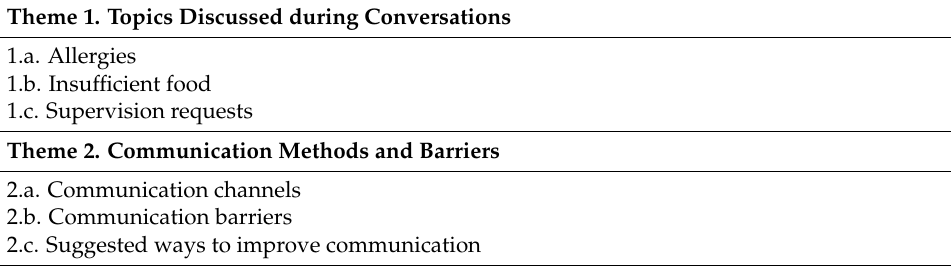
Table 2. Themes identified from parent and teacher